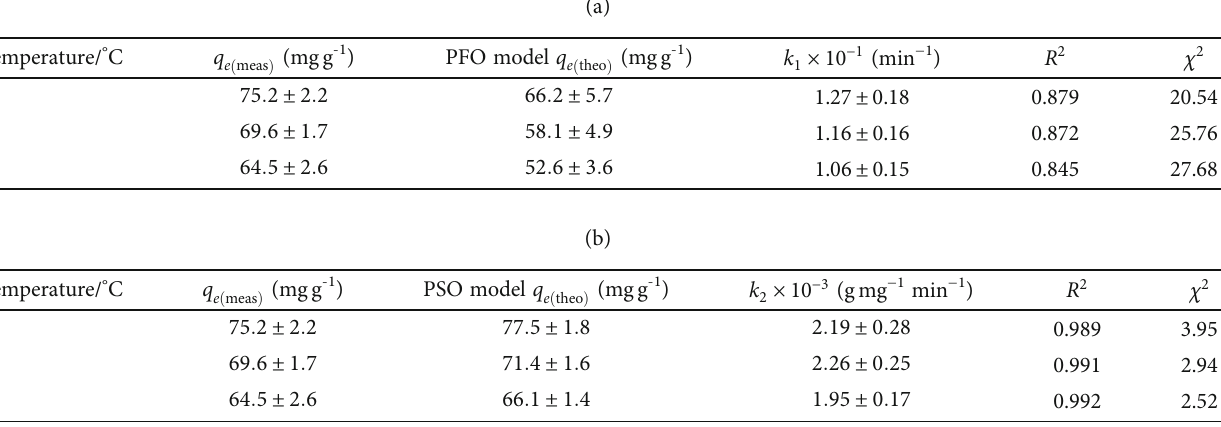
Table 3: Kinetic data for the uptake of BPA onto AgNP-SB- β CD nanocomposites.